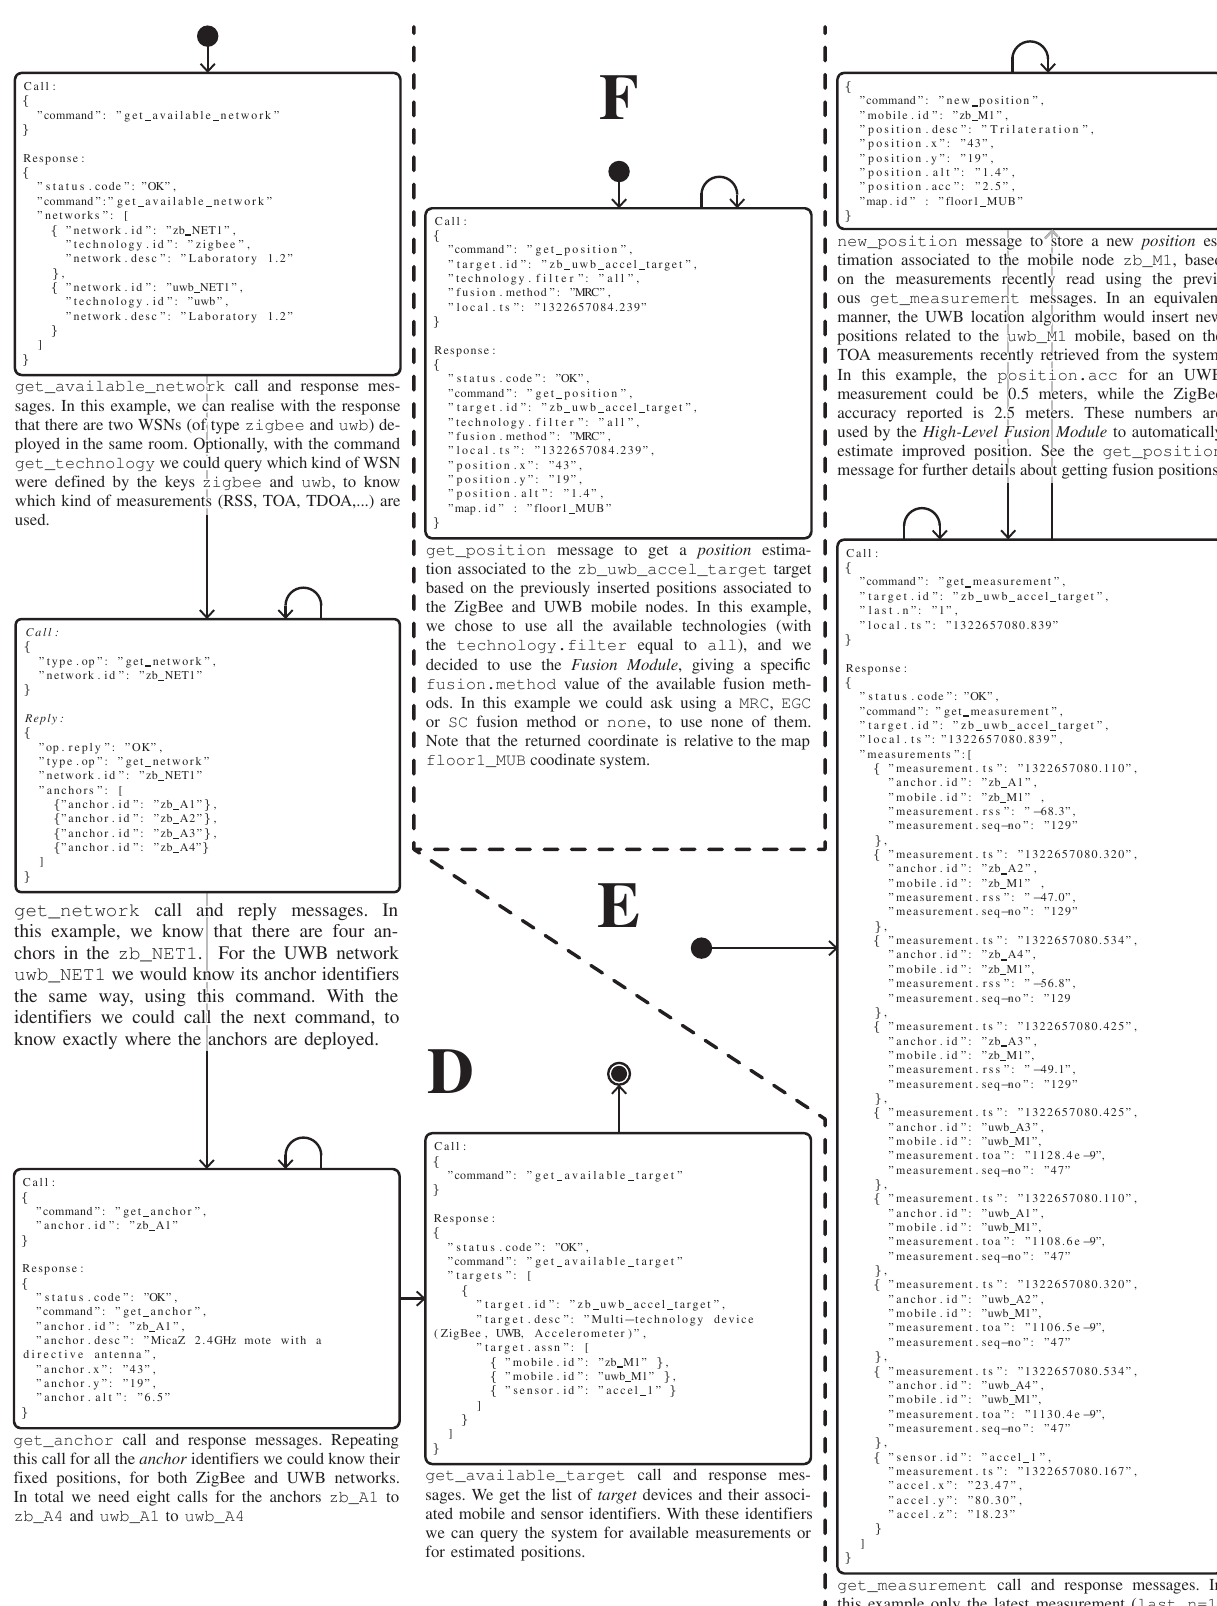
Figure 7. Groups of messages D, E and